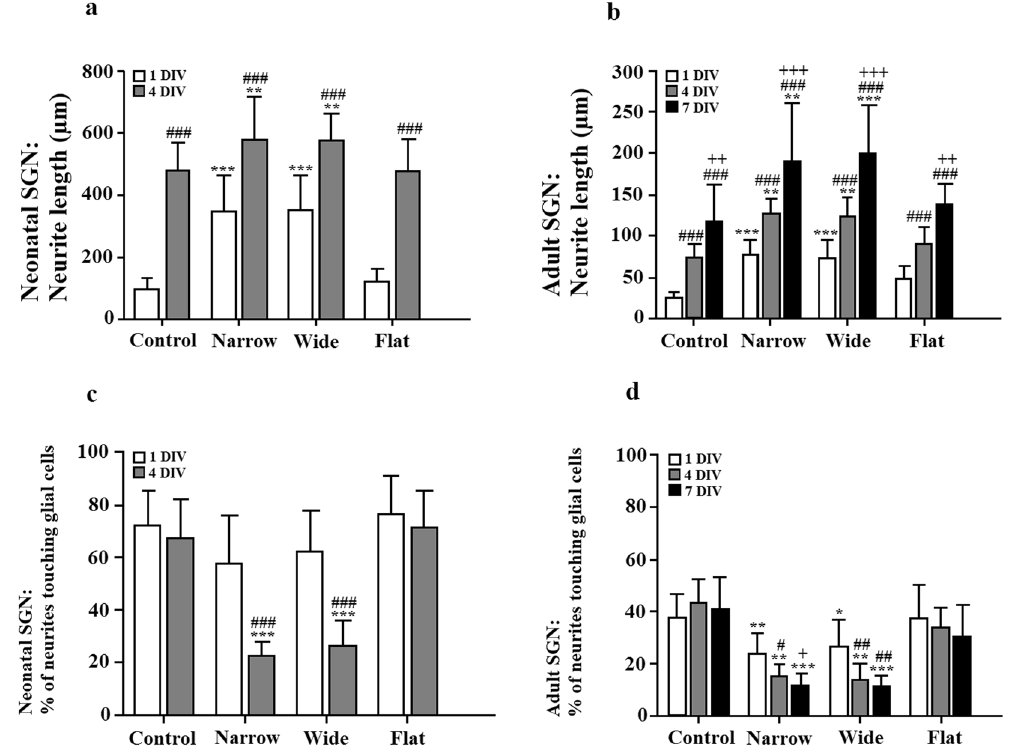
Figure 5. The effect of the CMOS area types on the neurite length and interaction with S100 + cells. ( a ) Bars and standard deviations show distribution of neonatal SGN neurite length as a function of time. # indicates differences by 1 DIV: ### P < 0.001 (Student’s t-test) and * indicates differences to control: ** P < 0.01, *** P < 0.001 and ns = not significant (Student’s t-test). ( b ) Bars and standard deviations show the distribution of adult SGN neurite length as a function of time. # indicates differences by 1 DIV: ### P < 0.001 (one-way ANOVA, Tukey post-hoc test), + indicates differences by 4 DIV: ++ P < 0.01, +++ P < 0.001 and * indicates differences to control: *** P < 0.001 and ns = not significant (one-way ANOVA, Tukey post-hoc test). ( c ) Quantification of the interaction of the neonatal SGN neurite with S100 + glial cells in the control condition and CMOS chips as function of time. # indicates differences by 1 DIV: ### P < 0.001 (Student’s t-test) and * indicates differences to control: *** P < 0.001 (Student’s t-test). ( d ) Quantification of the interaction of the adult SGN neurite with S100 + glial cells on control and CMOS chips. * indicates differences to control: * P < 0.05, ** P < 0.01, *** P < 0.001 (one-way ANOVA, Tukey post-hoc test), # indicates differences by 1 DIV: # P < 0.05 and ## P < 0.01 (one-way ANOVA, Tukey post-hoc test) and + indicates differences by 4 DIV: + = 0.05 (one-way ANOVA, Tukey post-hoc